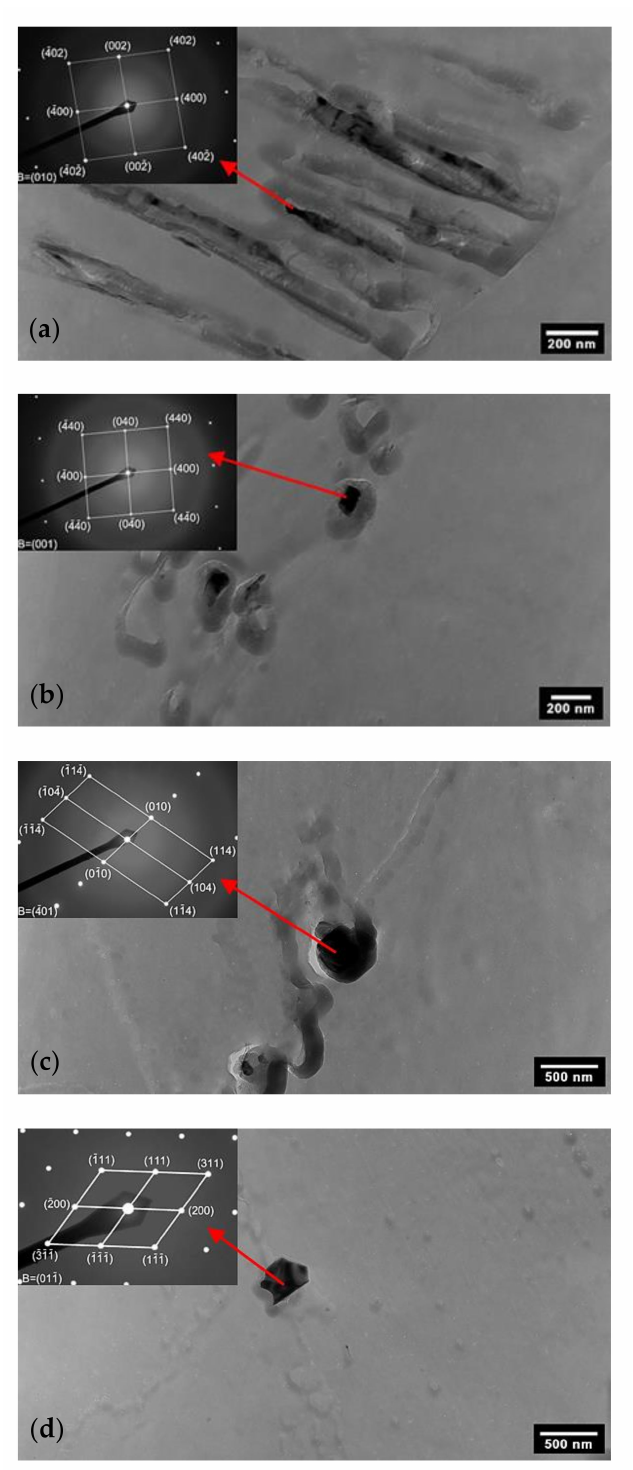
Figure 7. Secondary phases identified in AISI 316L (40% CW) with diffraction patterns corresponding to the marked particles (TEM of carbon extraction replicas): ( a ) sigma phase in 650 ◦ C/5 h conditions; ( b ) chi phase in 650 ◦ C/10 h conditions; ( c ) Laves phase in 650 ◦ C/10 h conditions; ( d ) M 23 C 6 in 650 ◦ C/10 h